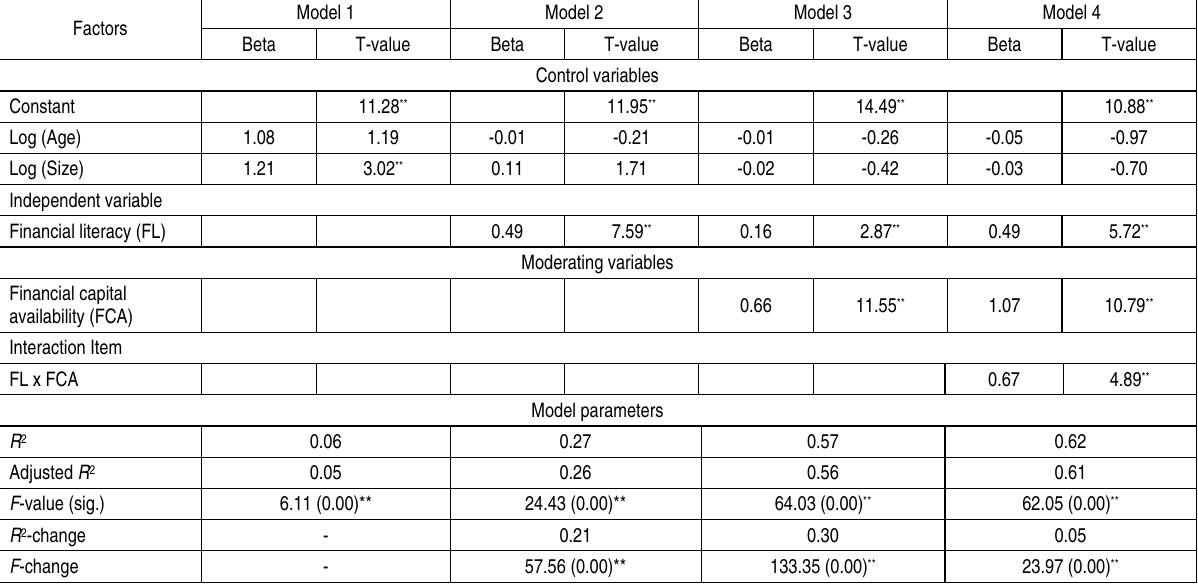
Table 2. Results on the moderating effect on financial capital availability